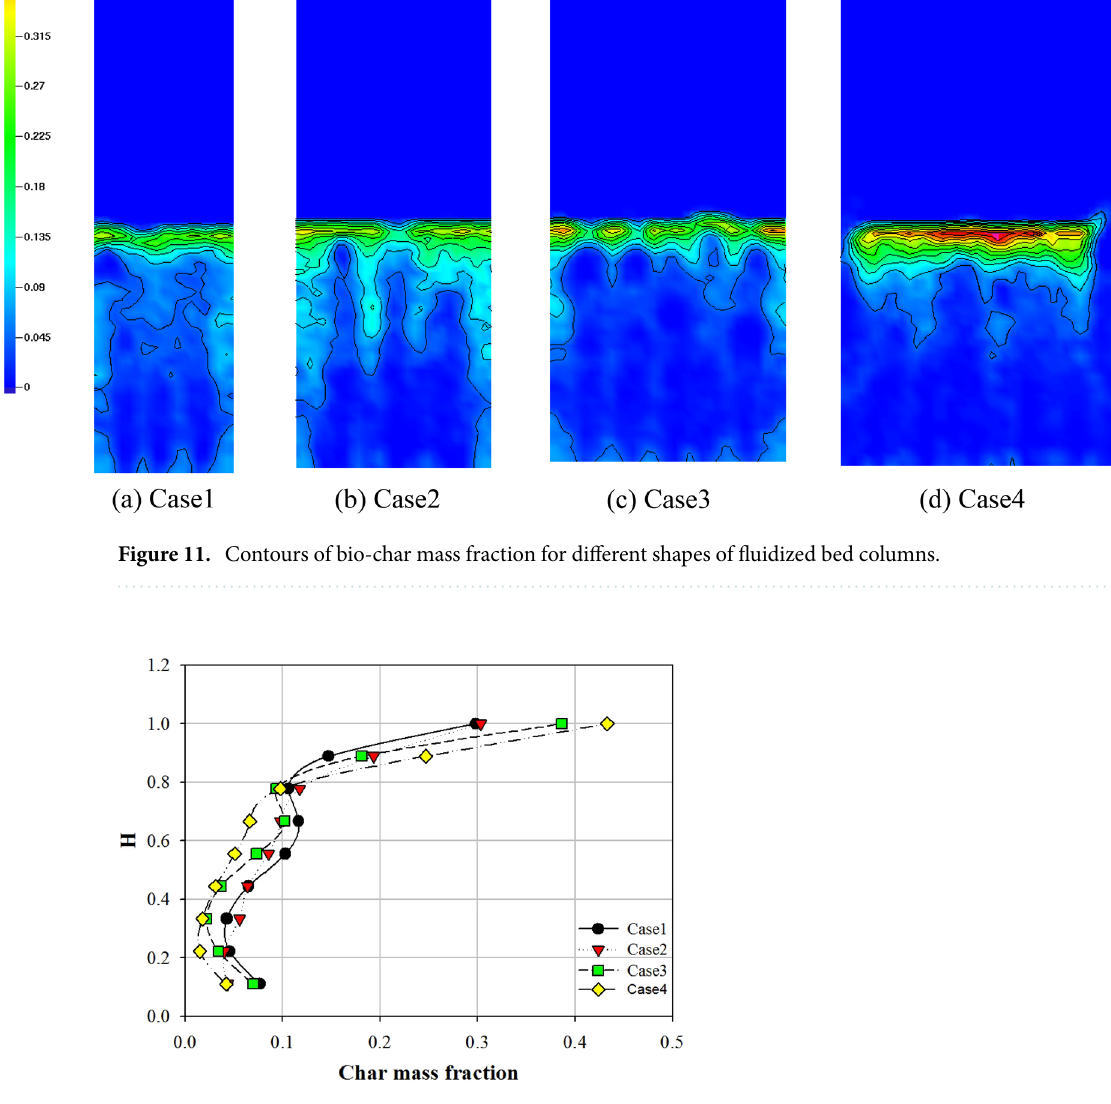
Figure 12. Axial bio-char mass fraction for different shapes of fluidized bed